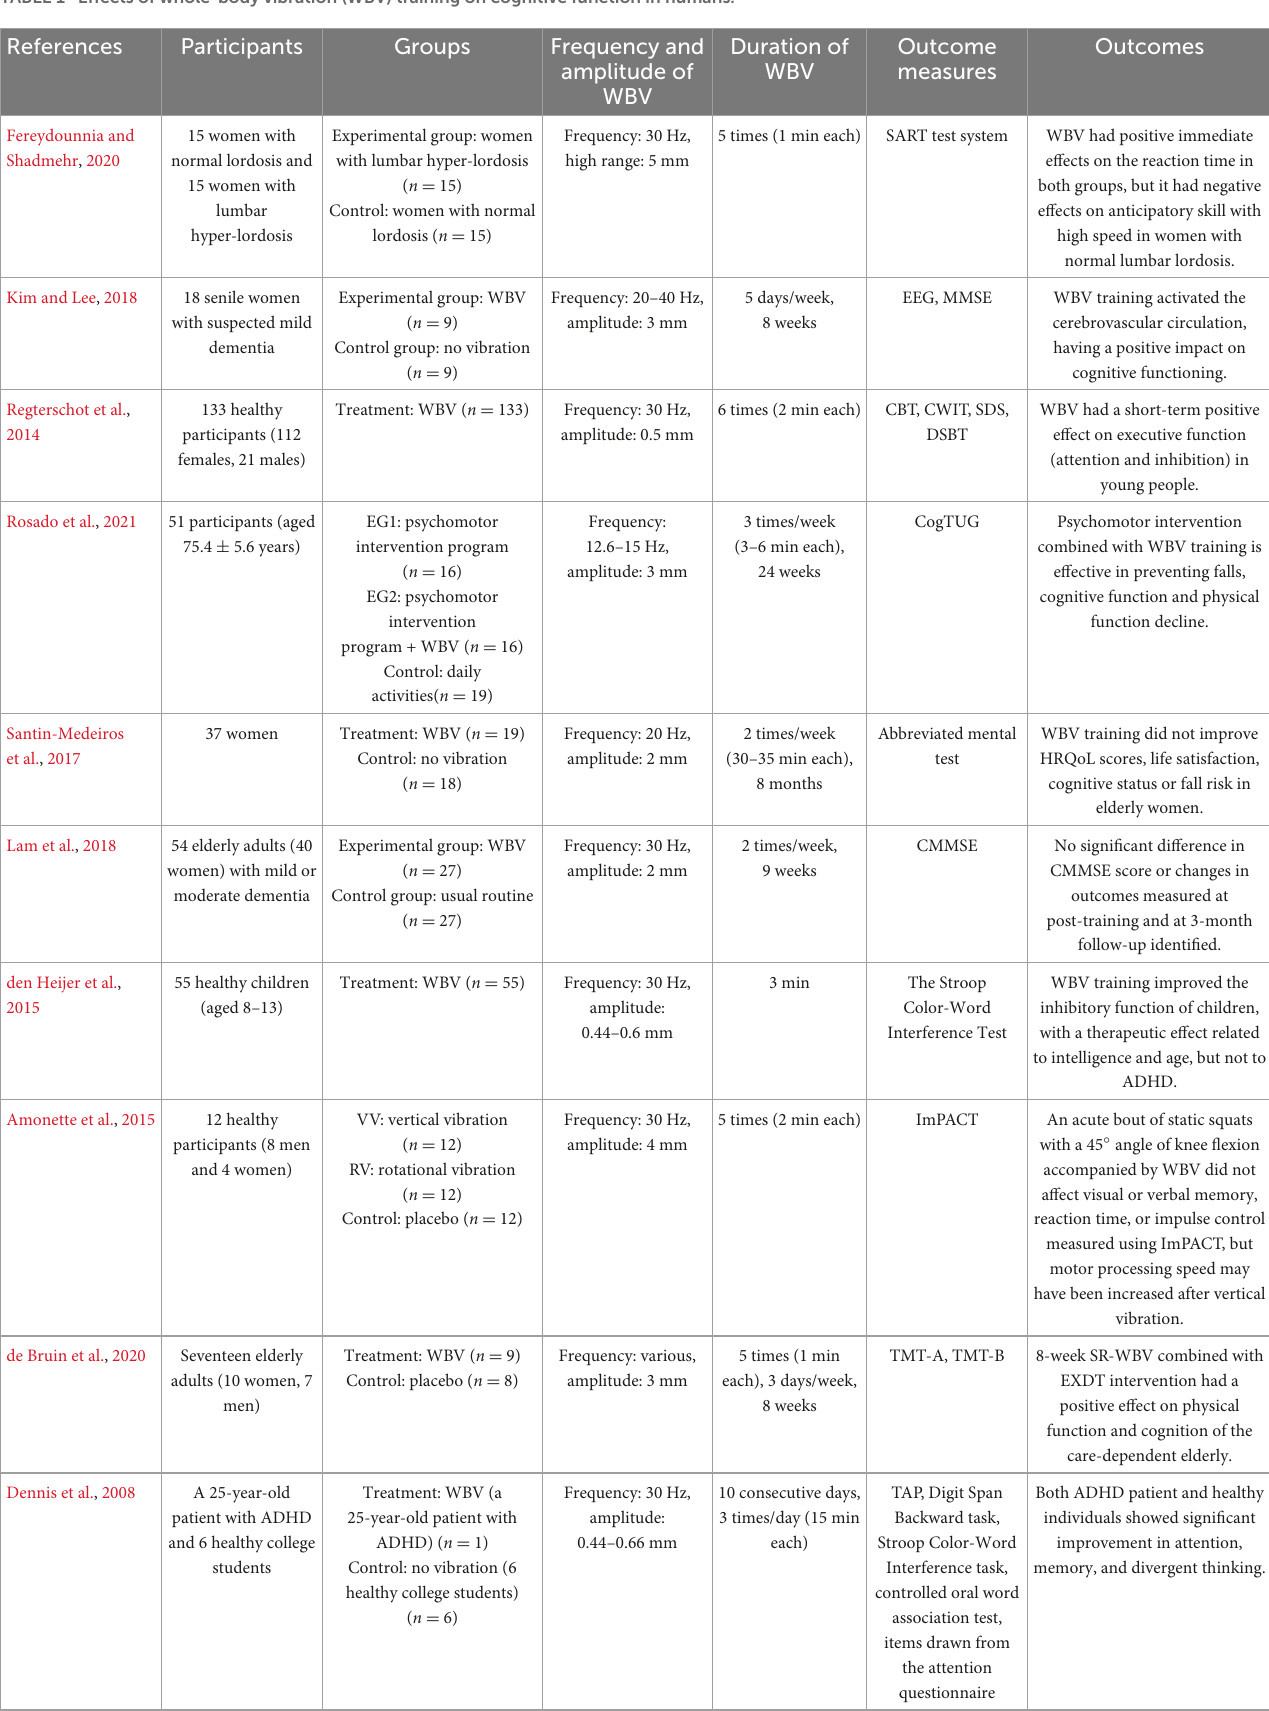
TABLE 1 Effects of whole-body vibration (WBV) training on cognitive function in